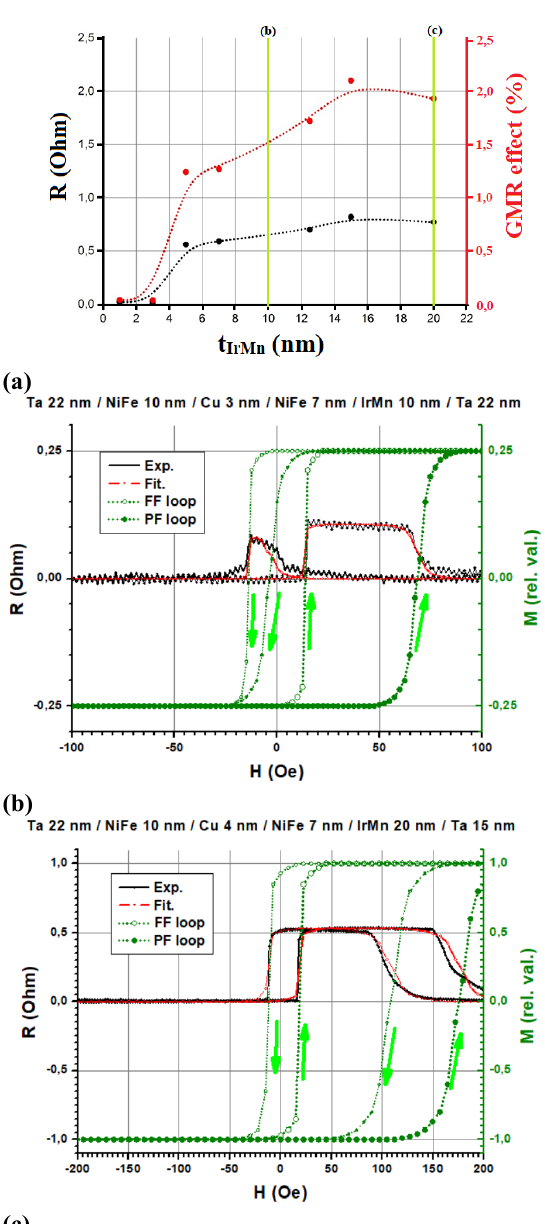
Fig.3 (a) AF thickness GMR dependence, absolute (black, Ohm) and relative (red, percent, the same scale) values. Experimental MR curves (black) with fitting (red) and derived hysteresis loops for FF and PF layers (green) for cases of 10nm- (b) and 20nm-thick (c) AF layer. Insufficient exchange bias (b) leads to superposition of hysteresis loops thus to GMR decrease.